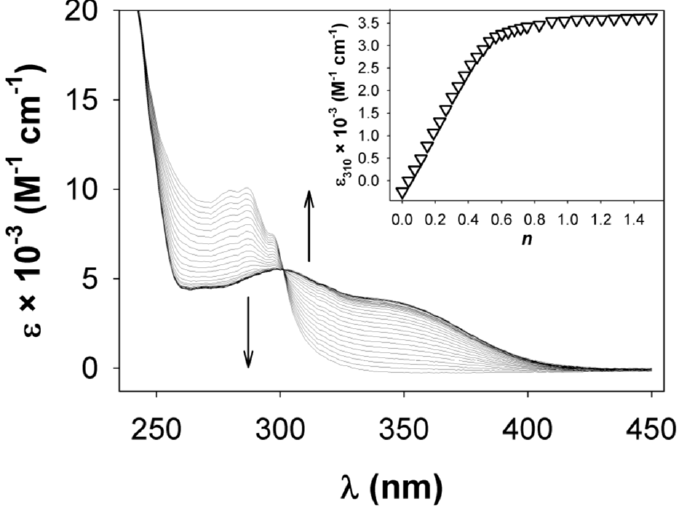
Figure 4. Absorption spectra recorded during the titration of a MeCN solution of 7a (10 − 5 M) with zinc(II) ion. In the inset, the titration profile shows the formation of a 1:2 adduct ( n = equiv. of Zn II ion/equiv. of 7a ).